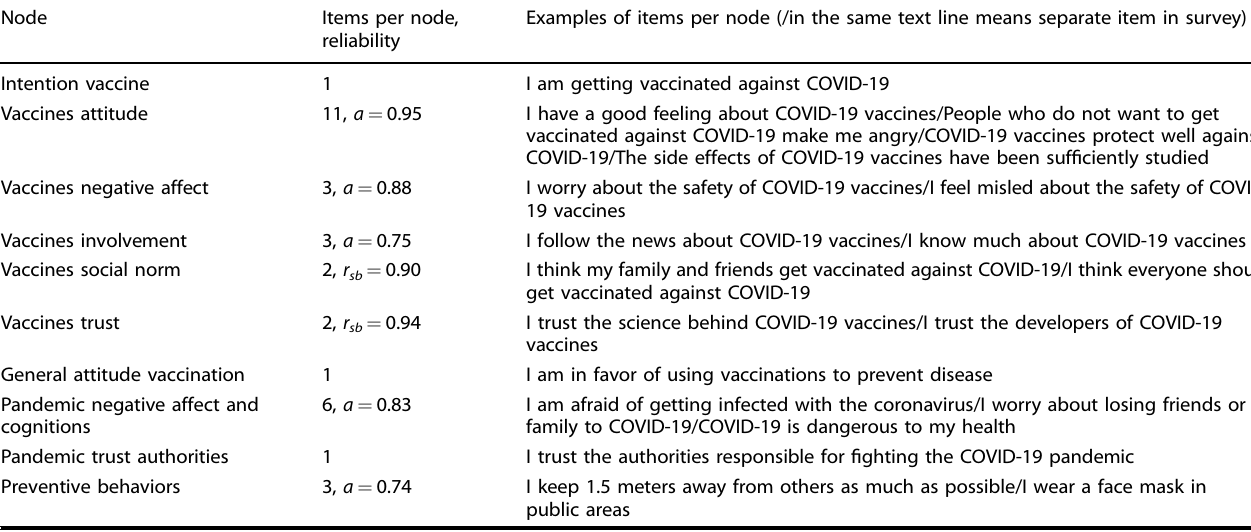
Table 5. Nodes (psychological variables) based on items in the survey, including item examples, number of items per node and reliability of nodes as observed in the current study (calculated with every respondent completing the survey in either of the six waves). Node Items per node,